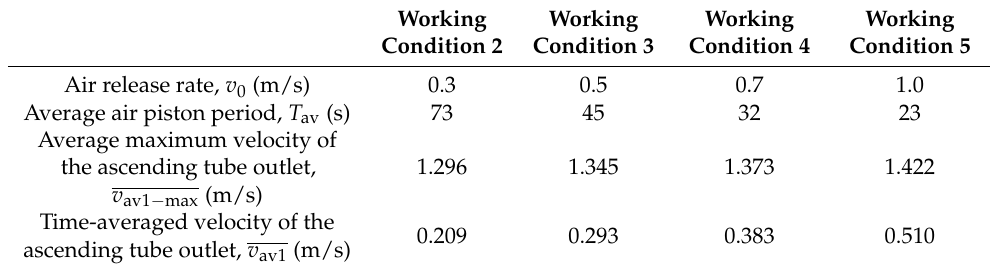
Table 2. Computational results of the water-lifting performance with different air release